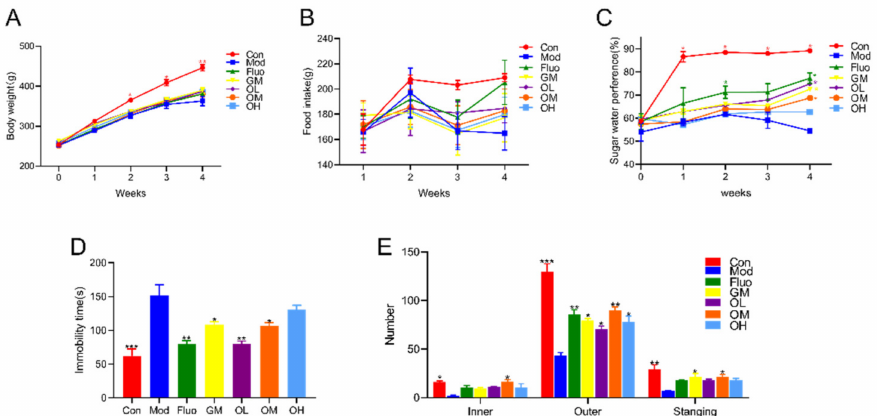
Figure 2. Jasmine tea ameliorated the depressive behavior induced by CUMS. ( A ). Body weight; ( B ). food intake; ( C ). sugar water preference; ( D ). immobility time in FST; ( E ). number in the OFT. Con, control group; Mod, CUMS group; Fluo, CUMS rats treated with fluoxetine; GM, CUMS rats treated with green tea dhool at a middle dose; OL, CUMS rats treated with jasmine tea at a low dose; OM, CUMS rats treated with jasmine tea at a middle dose; OH, CUMS rats treated at a jasmine tea with high dose. (* p < 0.05 vs. Mod, ** p < 0.01 vs. Mod, *** p < 0.001 vs. Mod).